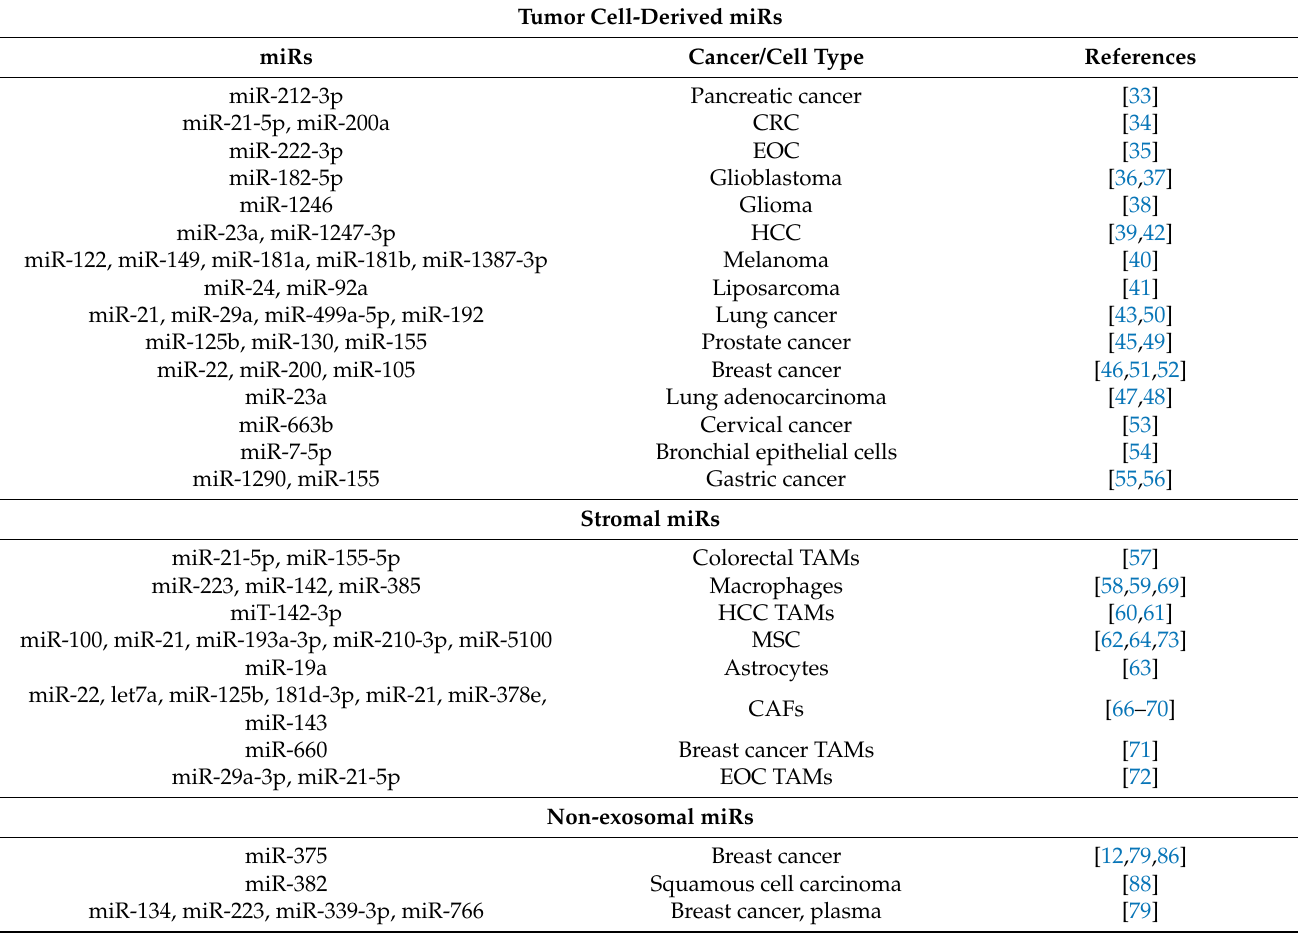
Table 1. Exosomal and non-exosomal miRs in the tumor microenvironment. Tumor Cell-Derived